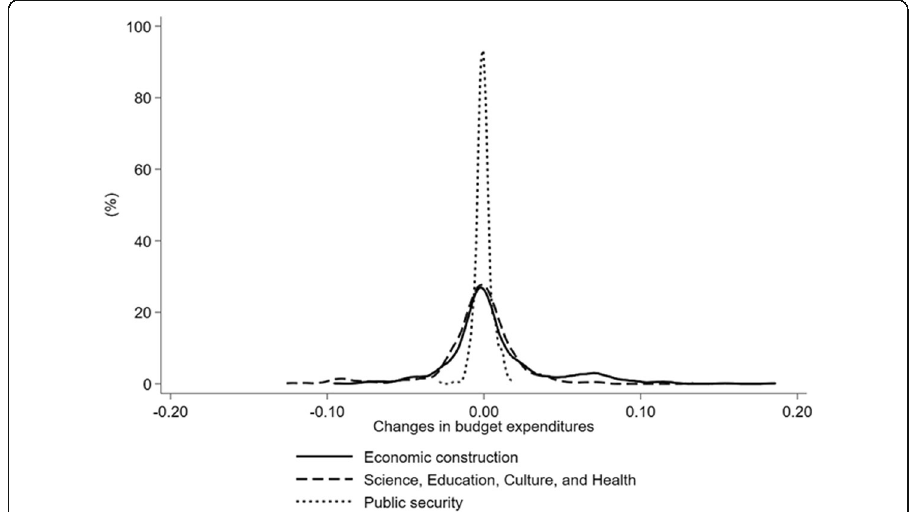
Fig. 2 Distribution of changes in various types of fiscal